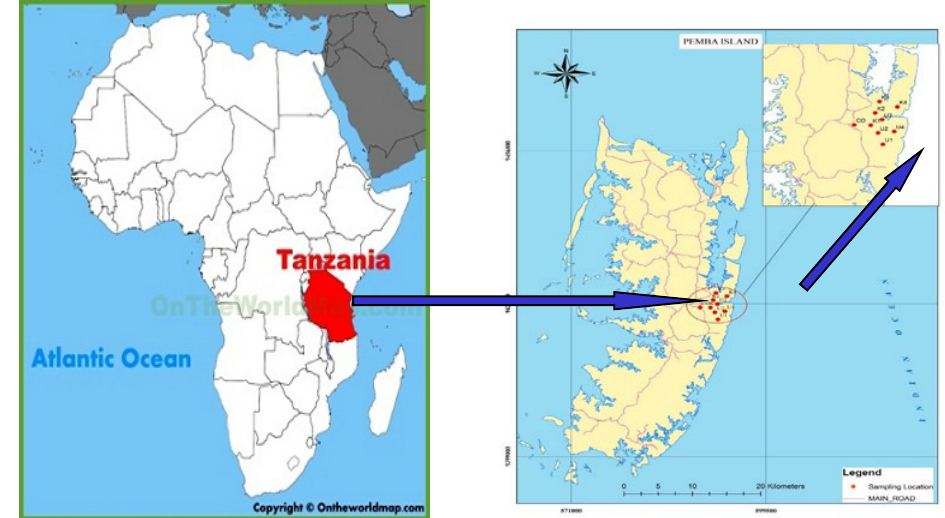
Fig. 1: The geographic location of the study area in Uwandani and Kangagani quarry Pemba-Island Zanzibar, Tanzania